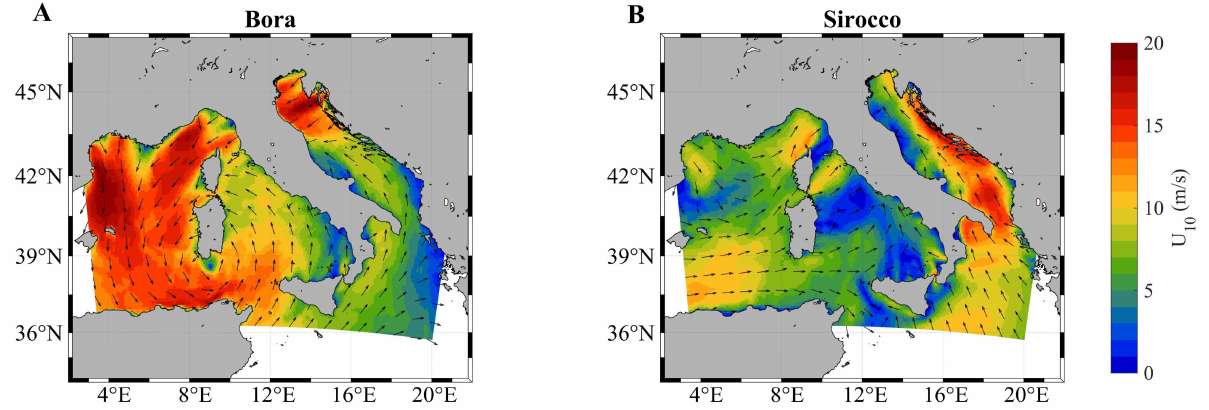
Figure 2. Example of near-surface U 10 wind fields (colored shading, units in m/s) simulated by the COSMO-CLM RCM over the Italian peninsula (at the center of the domain) and a portion of the Mediterranean Sea. ( A ) Northeasterly Bora wind in the Adriatic Sea and Mistral wind in the northern Mediterranean; ( B ) southeasterly Sirocco wind in the Adriatic Sea. The model wind is masked over land, and direction vectors (black arrows) are decimated with a factor of 10 for the sake of